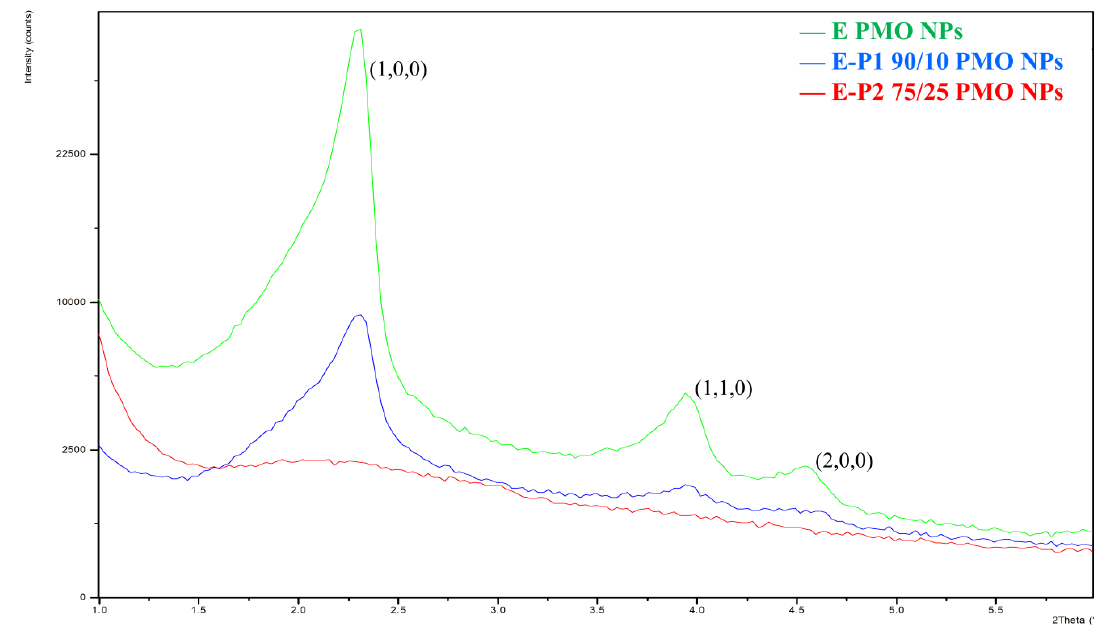
Figure 7. Small angle XRD diagram of E PMO NPs (green line), E-P1 90/10 (blue line), E-P1 75/25 (red line).